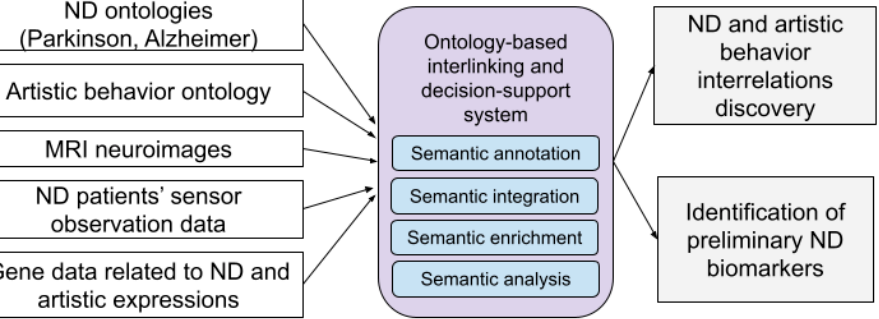
Figure 1. High-level design of a system realizing the proposed framework.